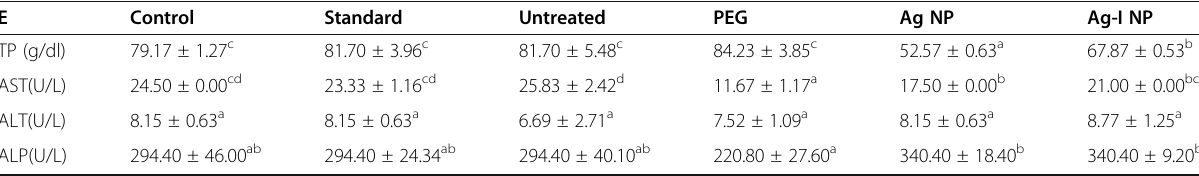
Table 3 Effects of 21-days treatment of wound with PEG, Ag NP and Ag-I NP on liver function enzymes of albino rats